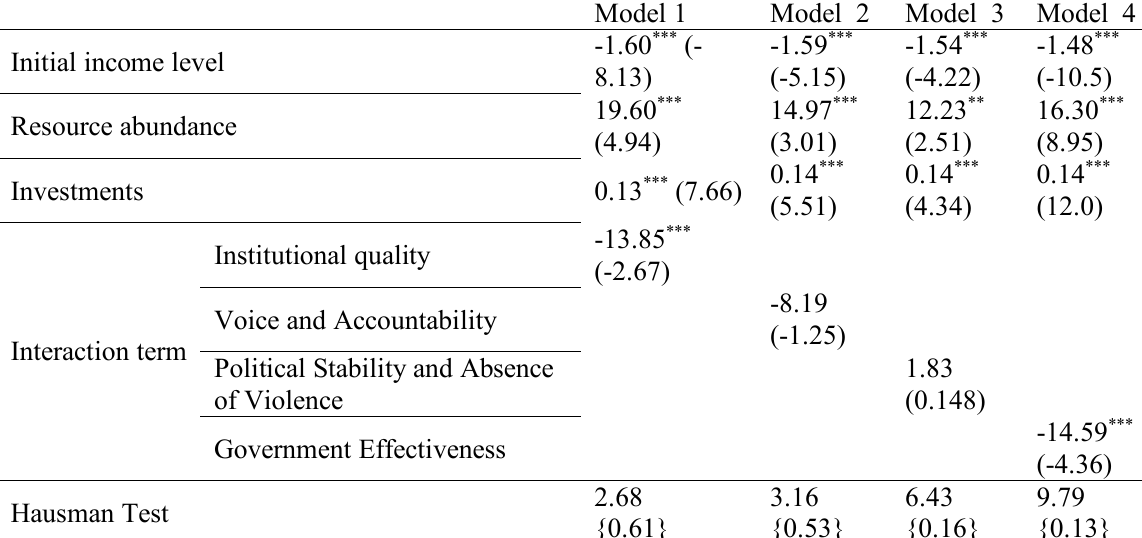
Table 2. Estimated results for the models 1 to 4